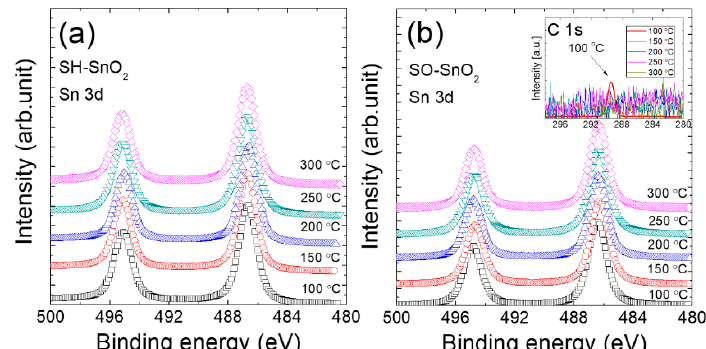
Figure 3. Sn 3 d XPS core level spectra of the SnO 2 films deposited at 100–300 °C using ( a ) Sn(dmamp) 2 /H 2 O plasma and ( b ) Sn(dmamp) 2 /O 2 plasma. Inset of Figure 3b shows the C 1 s X-ray photoelectron (XP) spectra of SO-SnO 2 films. photoelectron (XP) spectra of SO-SnO 2 films.